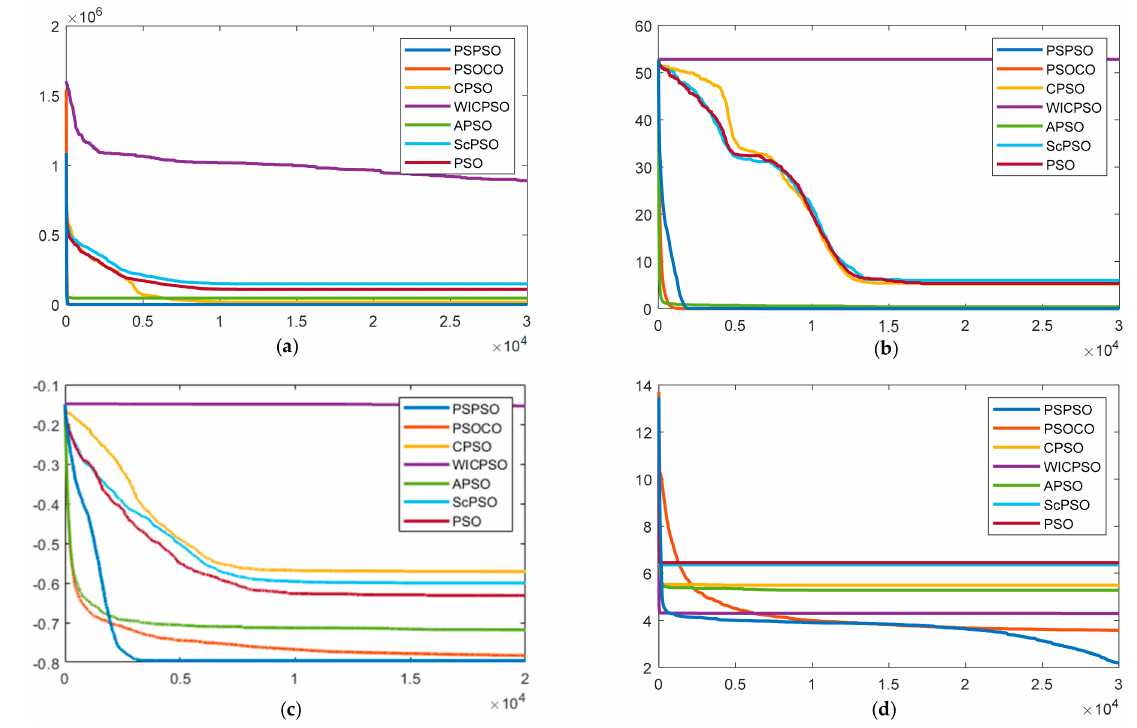
Figure 3. Average convergence of partitioned step particle swarm optimization (PSPSO) compared with different variants of particle swarm optimization (PSO) for ( a ) Rosenbrock, ( b ) Pinter, ( c ) G02, and ( d )